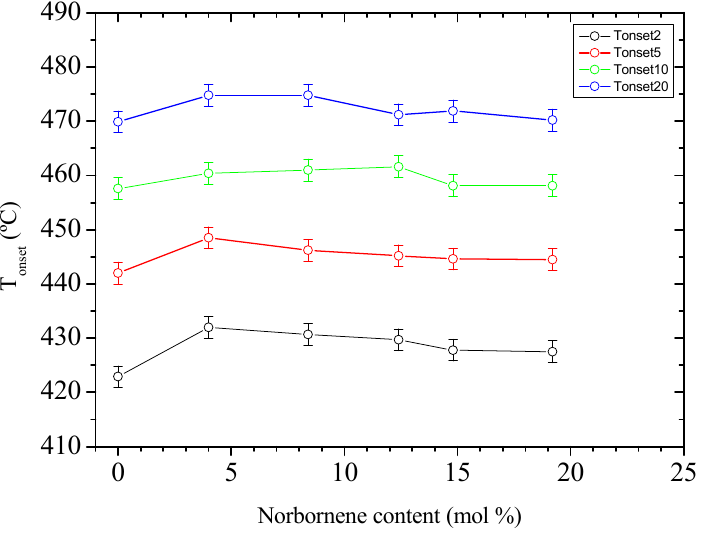
Figure 10. Onset temperatures of the degradation under nitrogen atmosphere (bars correspond to an error of ±2 °C).